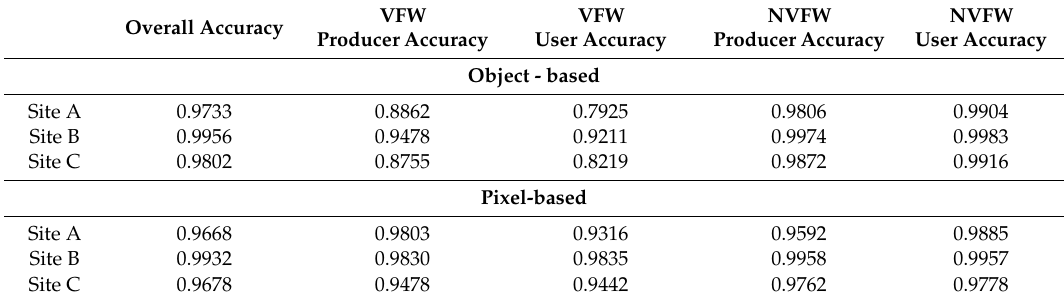
Figure 9. Segment-based (left) and pixel-based (right) mean accuracy depending on threshold ratios for FWI and D min for site A. Table 2. The highest achieved accuracies of visible floodwater (VFW) and non-visible floodwater (NVFW) for three test